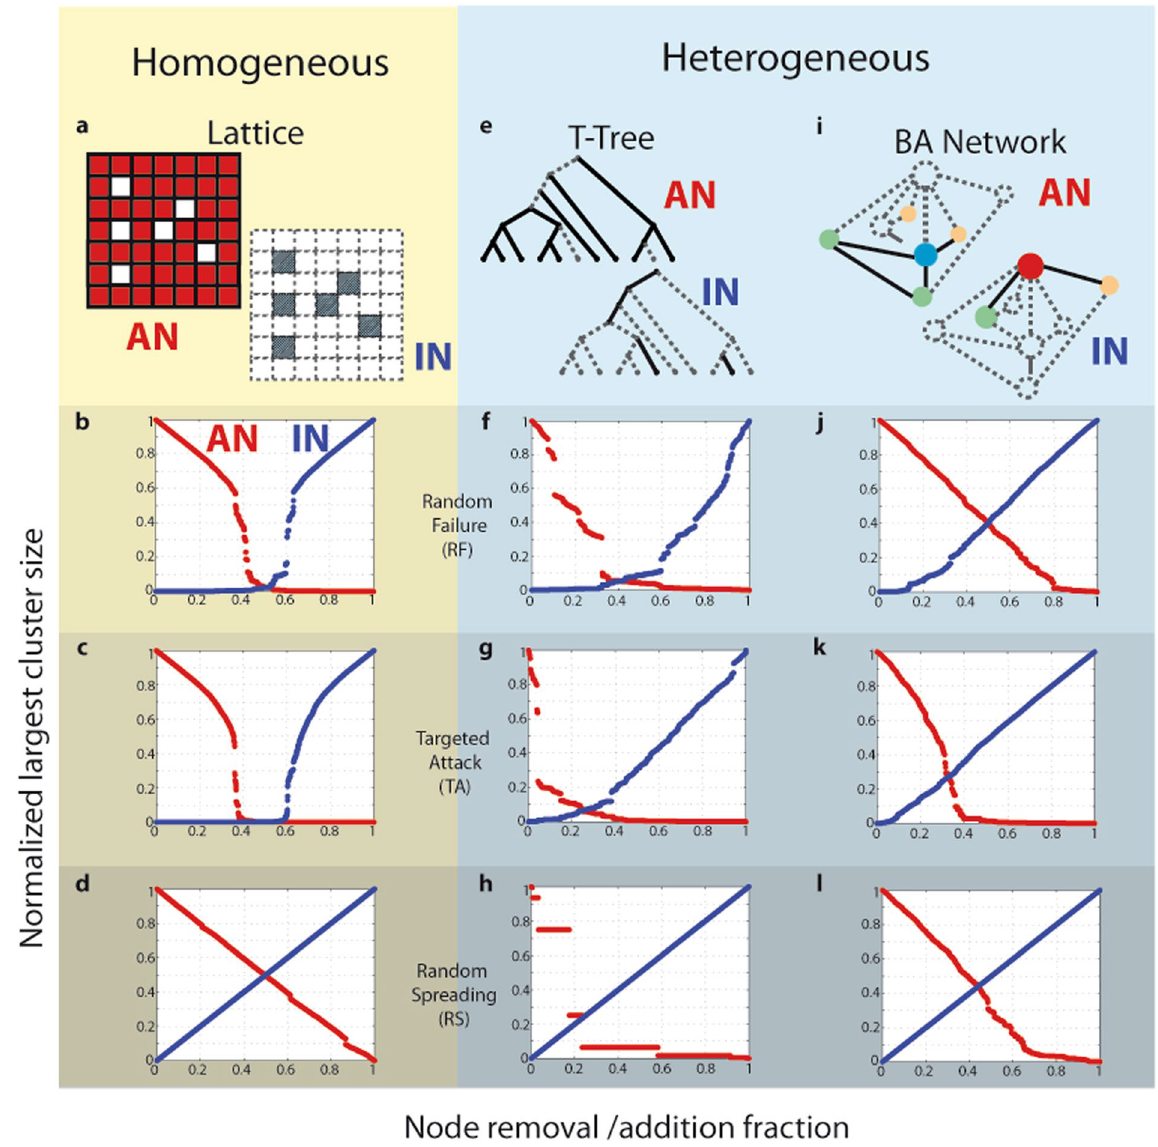
Figure 2. Dual connectivity perspective evolution of networks under attack. Evolution of the largest cluster size in the Active Network, AN (red) and Idle Network, IN (blue) for homogeneous (yellow panels) and heterogeneous (blue panels) networks with respect to three different sequential node removal strategies: panels ( b , f , j ) random failure, ( c , g , k ) targeted attack, and ( d , h , l ) random spreading. The largest cluster size and time are normalized by the system size. Three main observations are made: (i) the rate of decrease of the largest cluster size in the AN is not the same as the rate of increase of the largest cluster size in IN (asymmetric evolution); (ii) for homogenous networks and networks under random failure, there is a symmetry with respect to the vertical axis at 0.5 implying a complementarity in the efficiencies of destroying AN and building-up IN, i.e., E A + E I ≈ 1; and (iii) for heterogeneous networks (T-Trees and BA networks) and heterogeneous attacks (TA and RS) no symmetry is observed at all; there is a necessity to monitor both networks (AN and IN) since it is not possible to predict the value of the efficiency of building-up the IN from the efficiency value of destroying the AN and vice